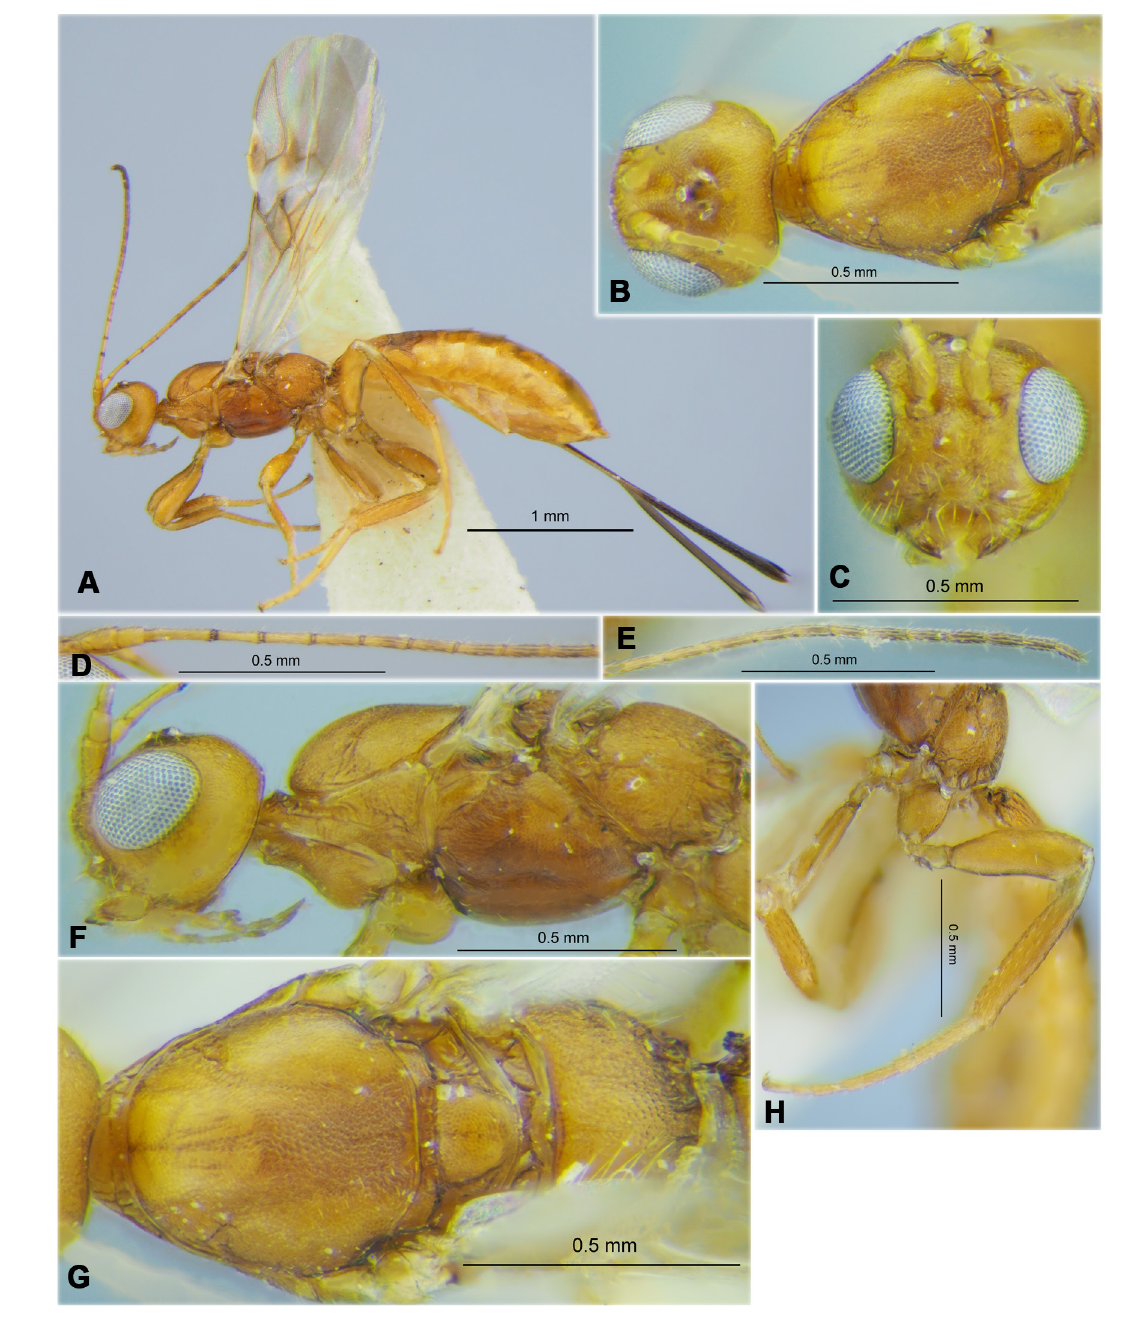
Fig. 32. Hecabalodes xylophagi Fischer, 1962, ♀ (RMNH). A . Habitus, lateral view. B . Head and mesoscutum, dorsal view. C . Head, front view. D . Basal segments of antenna. E . Apical segments of antenna. F . Head and mesosoma, lateral view. G . Mesosoma, dorsal view. H . Hind